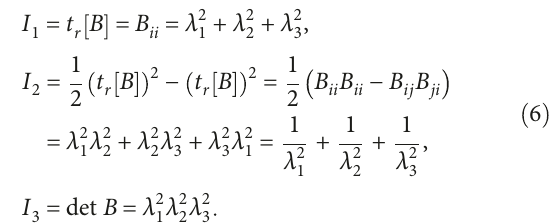
Figure 2: SEM image of a freeze-dried BMIMBF replacing the ionic liquid with water